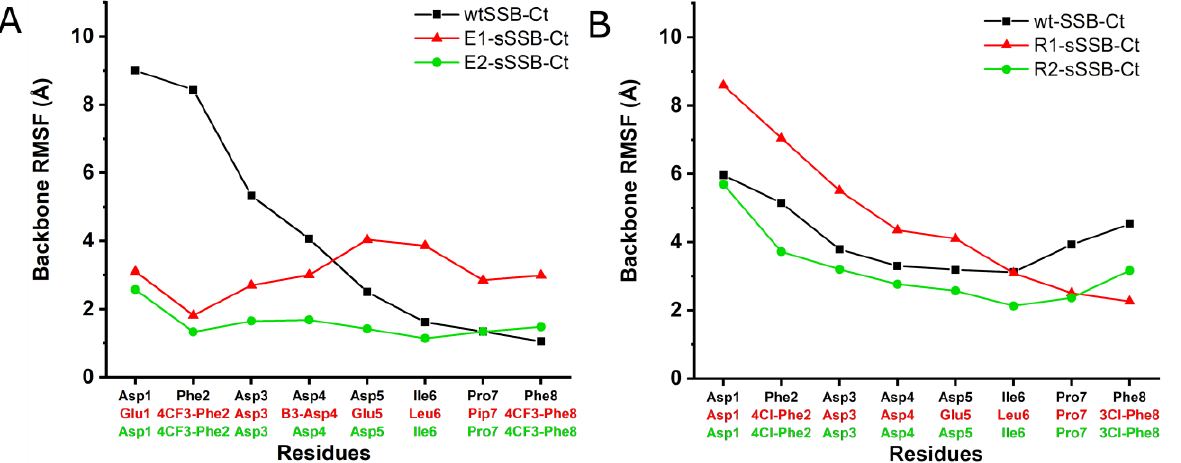
Figure 4. RMSF values of the backbone atom coordinates for wtSSB-Ct (black squares), E1-sSSB-Ct (red triangles), and E2-sSSB-Ct (green circles) in interaction with ExoI ( A ). RMSF values of the backbone atom coordinates displaying wtSSB-Ct (black squares), R1-sSSB-Ct (red triangles), and R2-sSSB-Ct (green circles) in interaction with RecO ( B ).